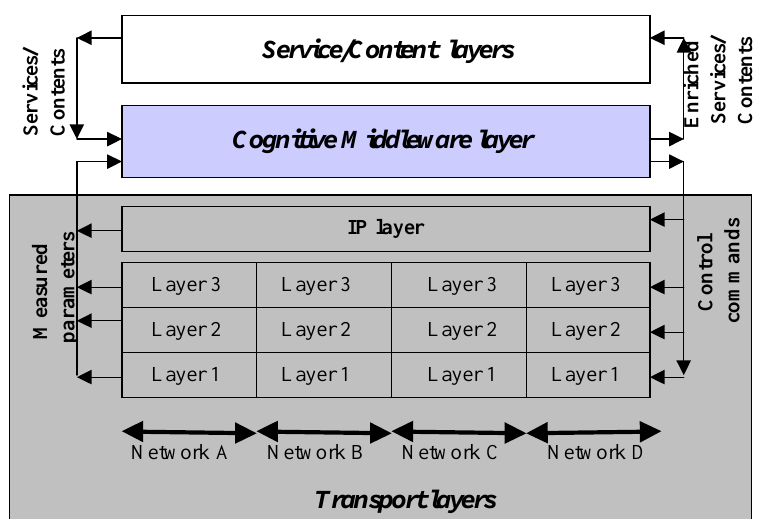
Figure 1. Proposed layering